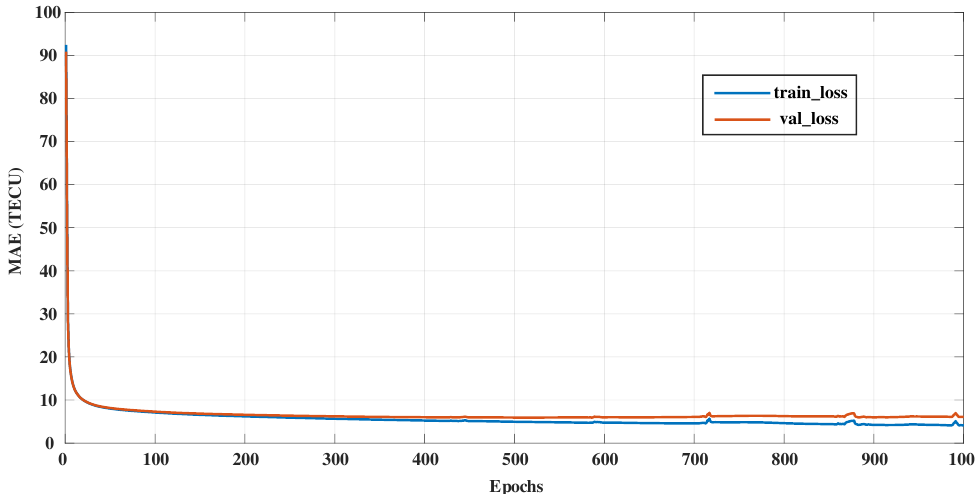
Figure 3. Variation curve of training set loss and validation set loss error with